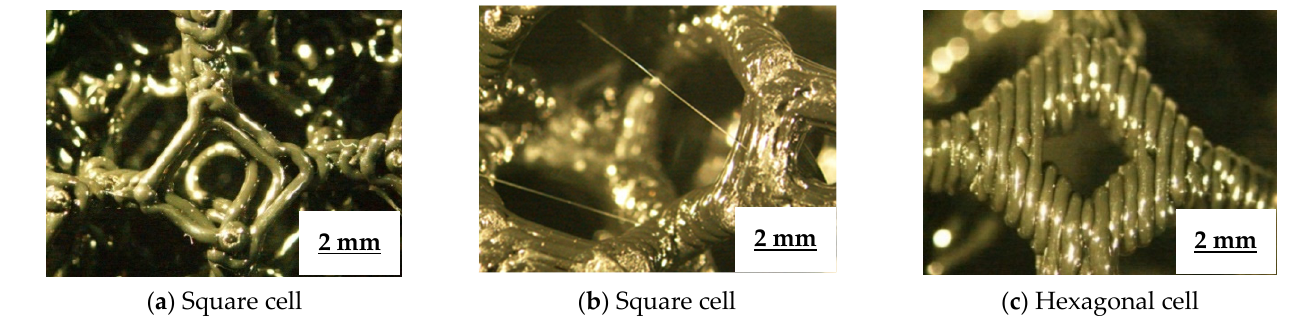
Figure 7. Stereo microscope images (10×). ( a ) Layer detachment. ( b ) Stringing. ( c ) Absence of defects after the definition of the printing parameters.